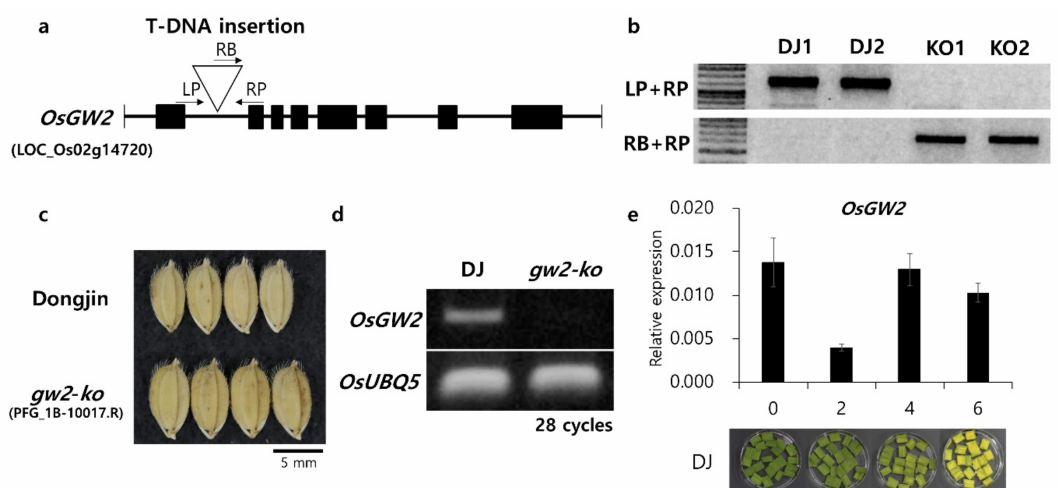
Figure 4. OsGW2 T-DNA insertion knock-out mutant ( gw2-ko ) in wild-type Dongjin genetic background. ( a ) Schematic diagram showing the location of T-DNA insertion of the PFG_1B-10017.R mutant. ( b ) T-DNA insertion was confirmed using two sets of primers indicated in ( a ), and lines homozygous for the T-DNA insertion were used for this experiment. ( c ) Comparison of grain shape between wild type and gw2-ko . ( d ) Confirmation of OsGW2 knock-out by semi-quantitative RT-PCR. OsUBQ5 was used as a loading control. ( e ) Gene expression pattern of OsGW2 during the dark-induced senescence. The transcript level of genes was determined by qRT-PCR. OsUBQ5 was used for